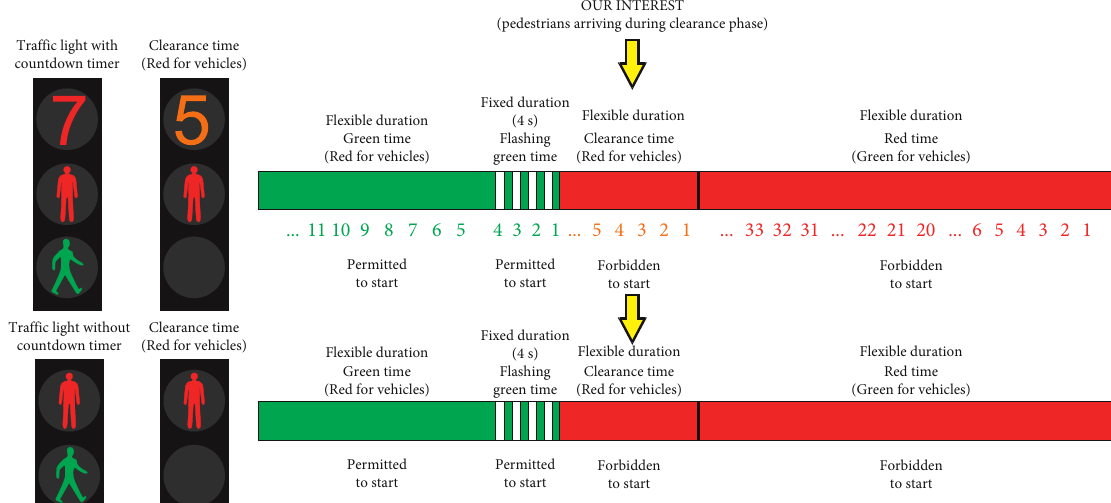
Figure 1: Design of pedestrian traffic lights with and without the countdown timer at the study